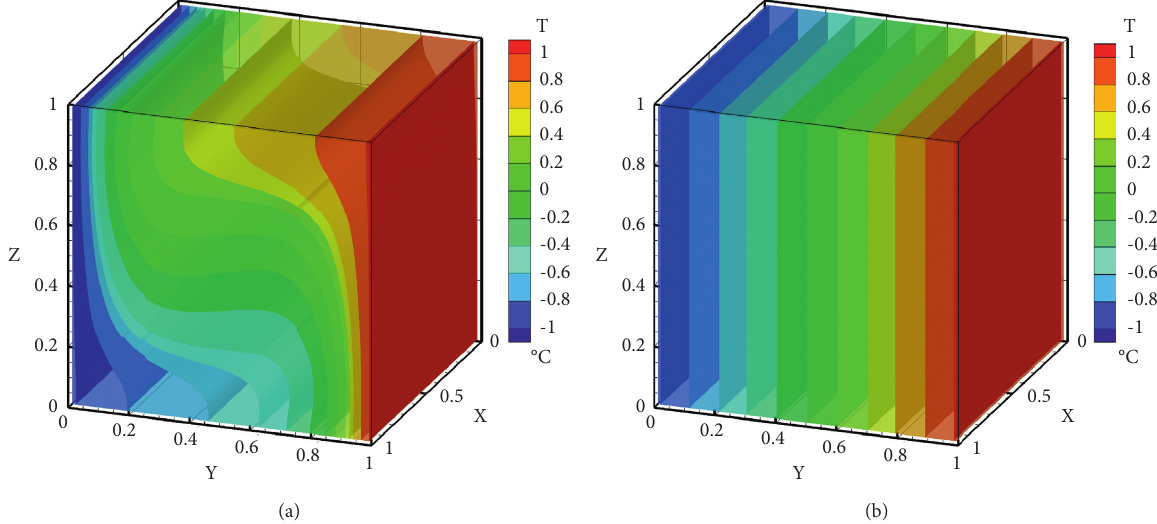
Figure 3: Isothermal surfaces. (a) Added driving flows. (b) Opposed driving flows.